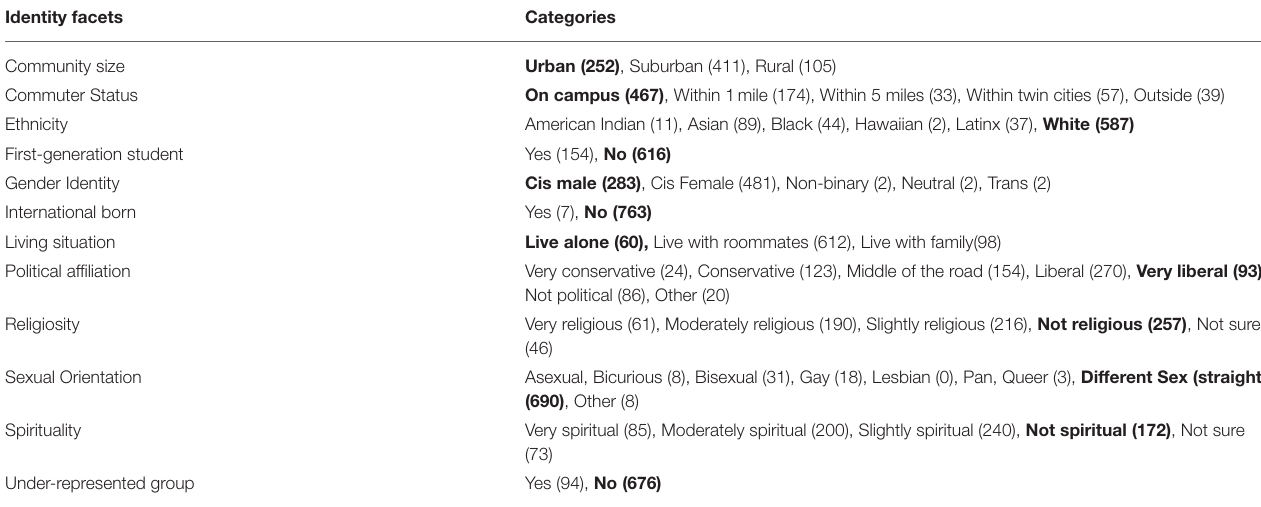
TABLE 2 | Identity facets and categories of each facet. Identity facets